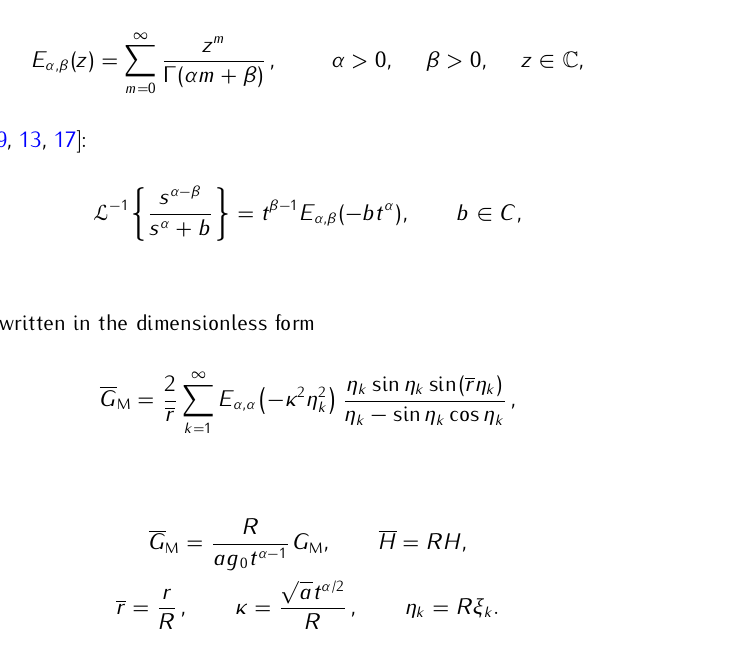
Figure 1. Dependence of fundamental solution G